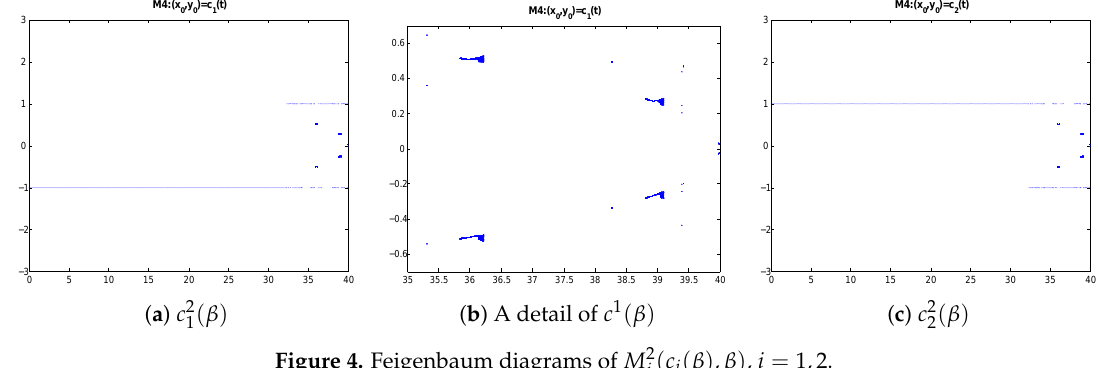
Figure 4. Feigenbaum diagrams of M 2